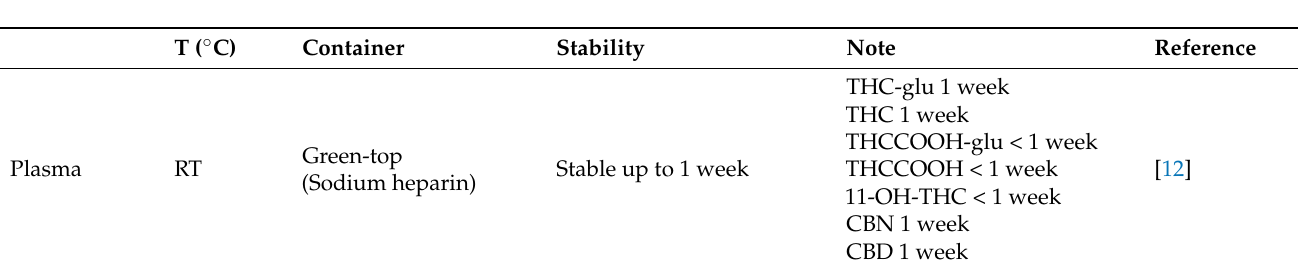
Table 2. Duration of storage stability for cannabinoids in plasma based on temperature and collec- tion